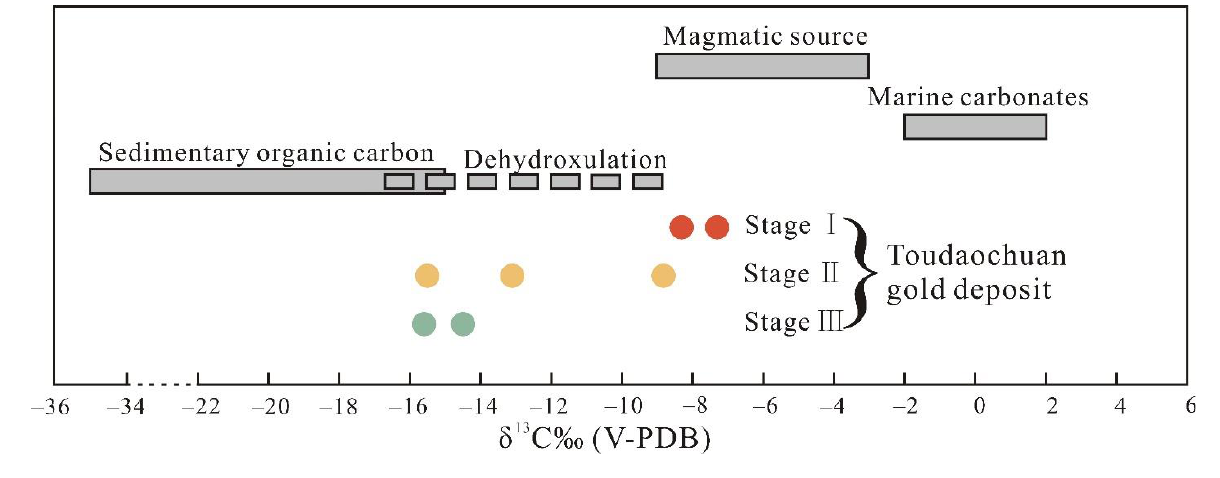
Figure 9. The diagram of carbon isotopic compositions of the ore fluids for the Toudaochuan deposit (after Niu et al. [51]).